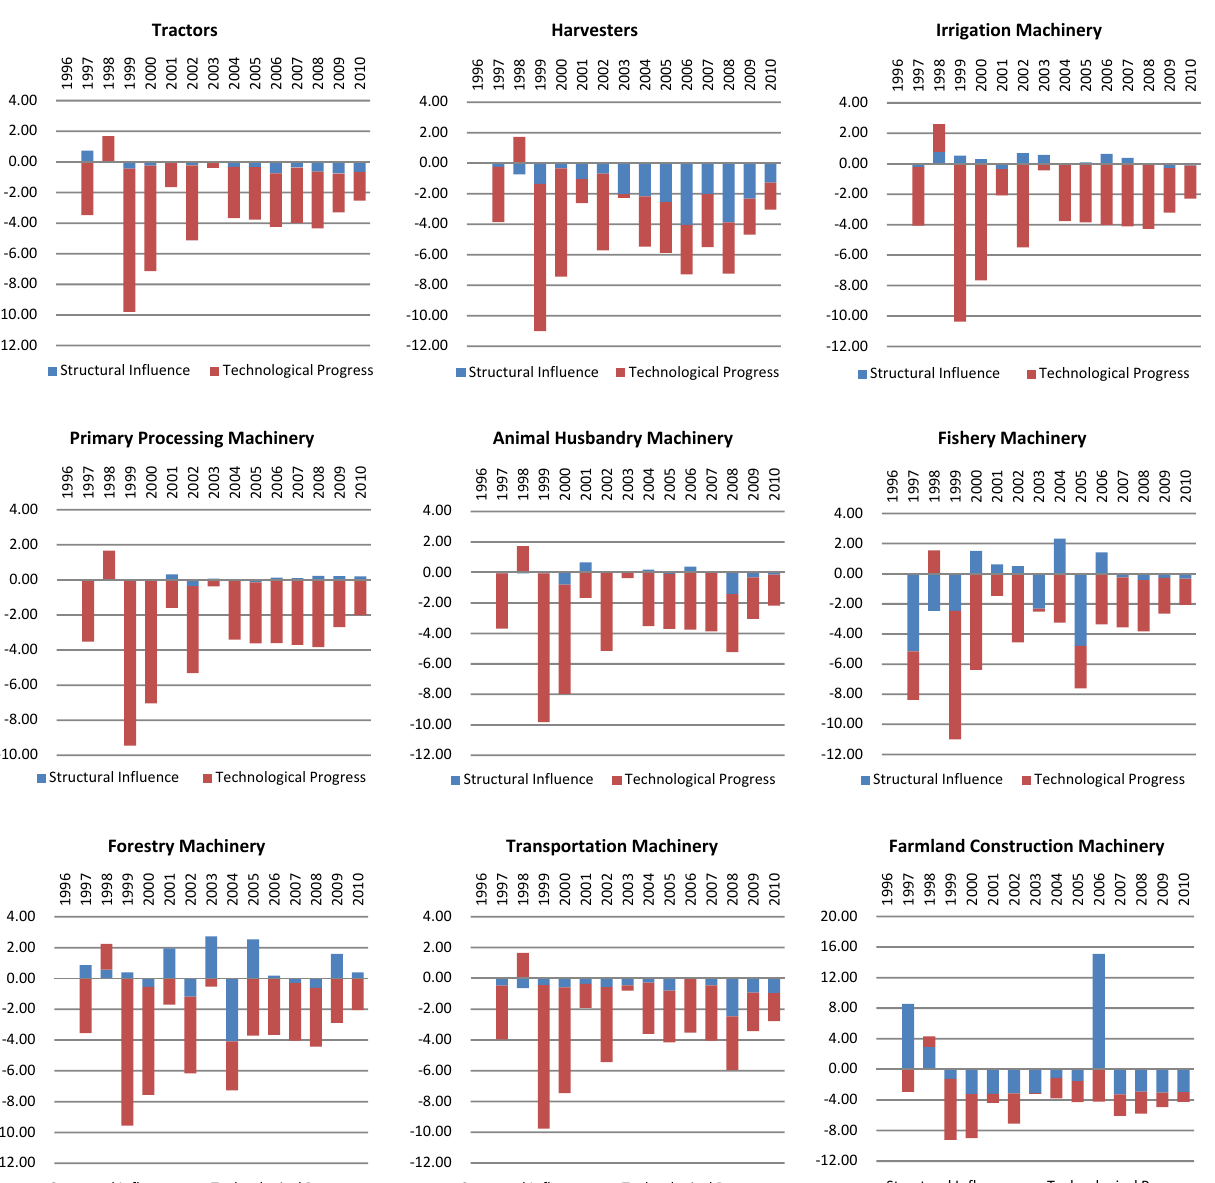
Figure 6. Changes in unit diesel consumption compared with that in the previous